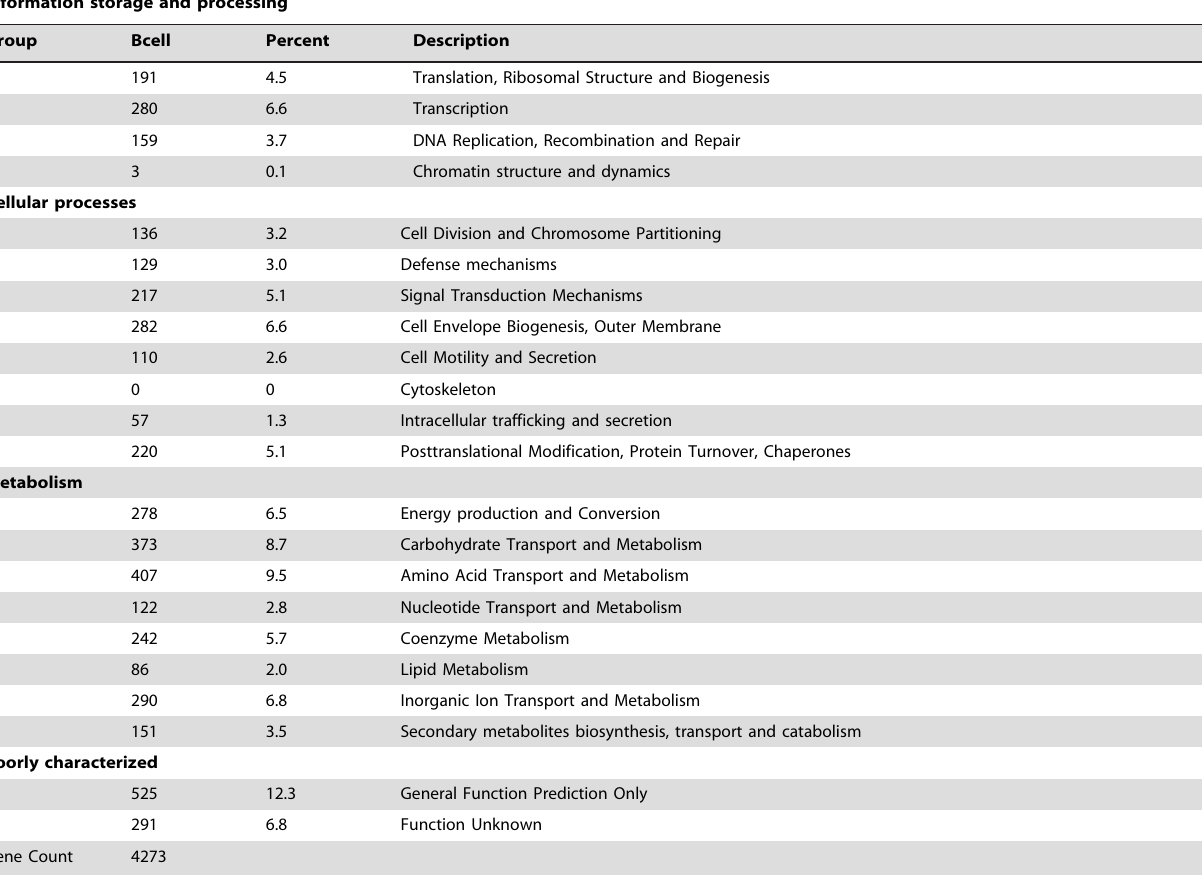
Table 2. COGS Functional